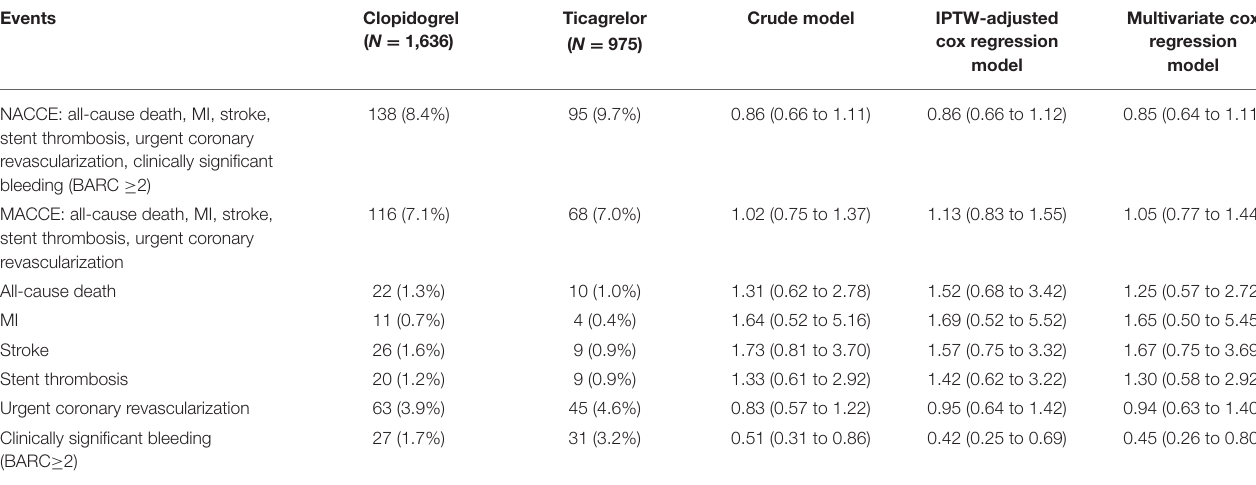
TABLE 2 | Risk for primary and secondary endpoints at 12 months after PCI.